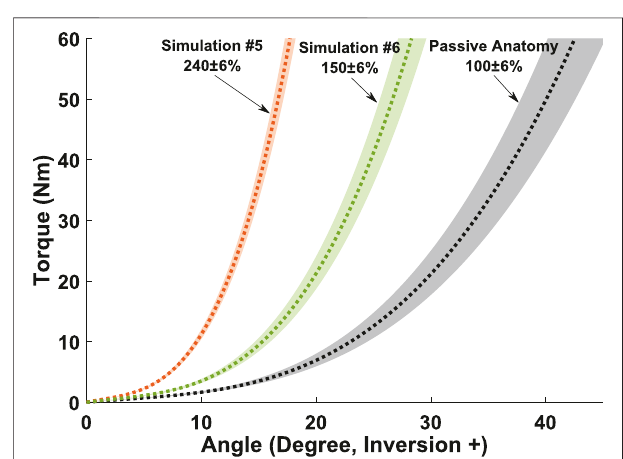
FIGURE 2 | Passive bushings were used to separately model the net effect of passive anatomy (ligaments, cartilage, etc.) and protective bracing applied between tibia and calcaneus reference frames. Inversion angle corresponds to rotation about an anterior-posterior, calcaneus- fi xed axis. Applied bracing was scaled as a function of passive anatomy to aid physical interpretation. Angular displacement values at fi xed torque levels were multiplied, such that a brace with a 150% scale factor would yield 50% less excursion, relative to baseline passive anatomy under the same applied torque. Flexibility was scaled, versus compliance (multiplying torque data), as fl exibility has been shown more in fl uential in prior ankle sprain simulations (Wright et al.,